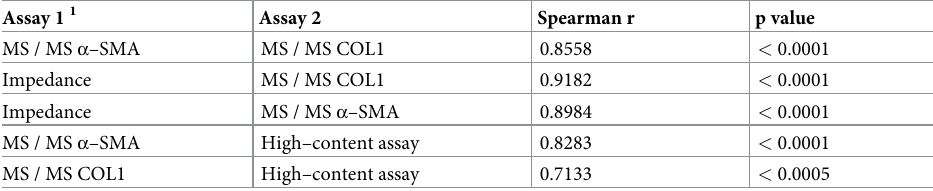
Table 2. Correlation of IC 50 values between assay read–outs for 20 compounds inhibiting TGF– β 1